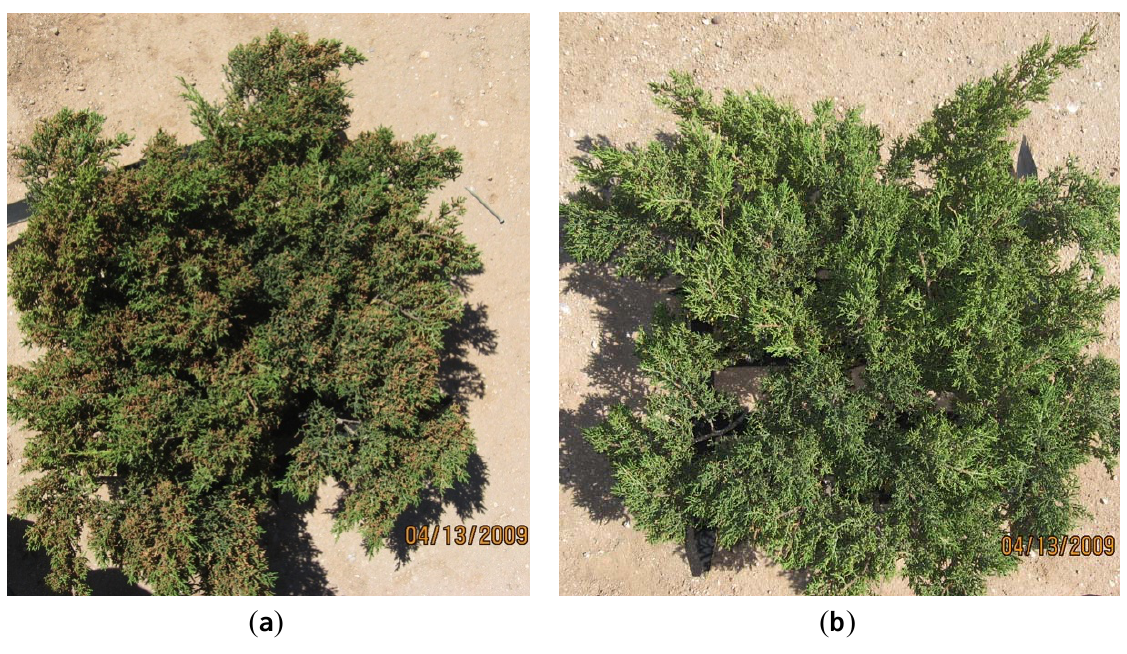
Figure 1. Juniper canopy ( a ) full of cones and (b) with no